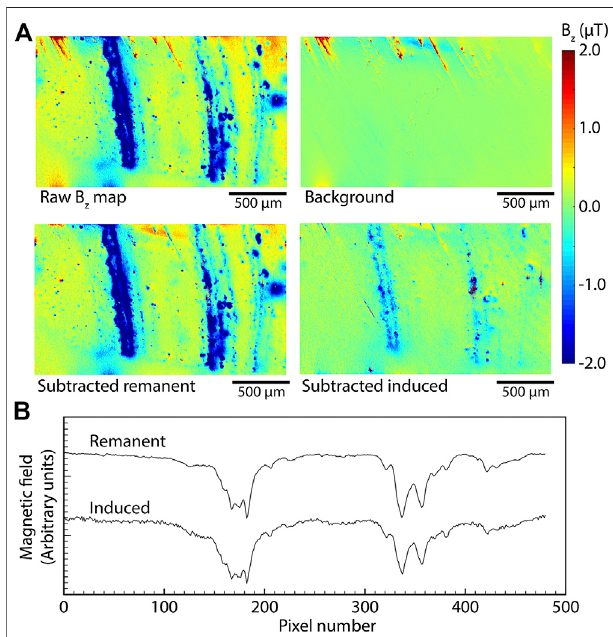
FIGURE 5 | Examples of high-resolution remanent and induced magnetization maps and demonstration of background subtraction. (A) Map of magnetic fi elds over the oldest of three mapped sections of the ALHO6 speleothem corresponding to approximately the 957 – 987 CE interval withtimeprogressingtowardtheright.Samplehasbeenimpartedwitha1.5 T IRM in the into-the-plane (negative) direction. Positive and negative values denote the intensity of the magnetic fi eld component out of and into to the mappingplane,respectively. (B) Fieldvaluesintheremanentandinduced fi eld maps averaged across lines of equal deposition